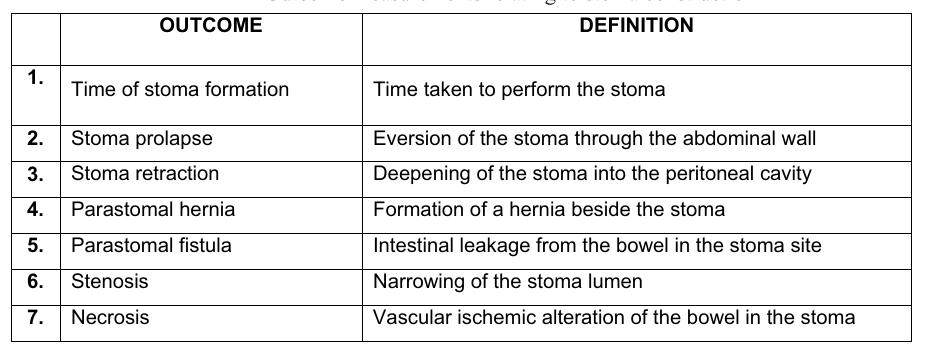
TABLE 2 - Outcome measurements relating to stoma construction